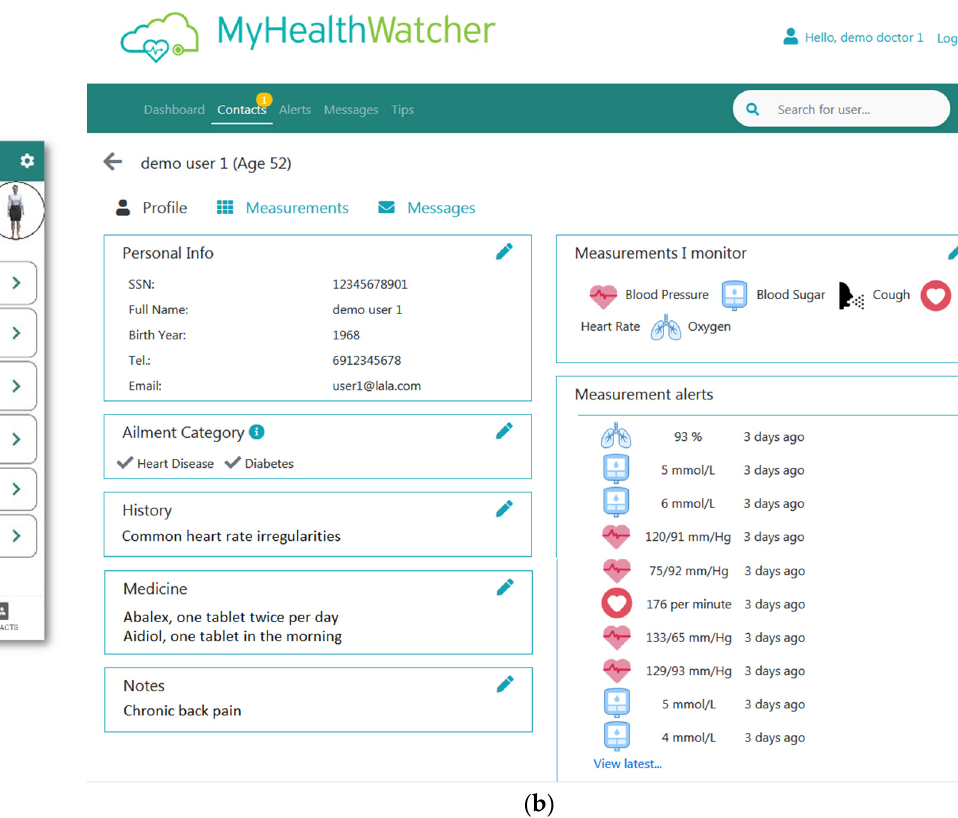
Figure 2. ( a ) Mobile app. ( b ) Secondary user side example—patient’s profile view page.